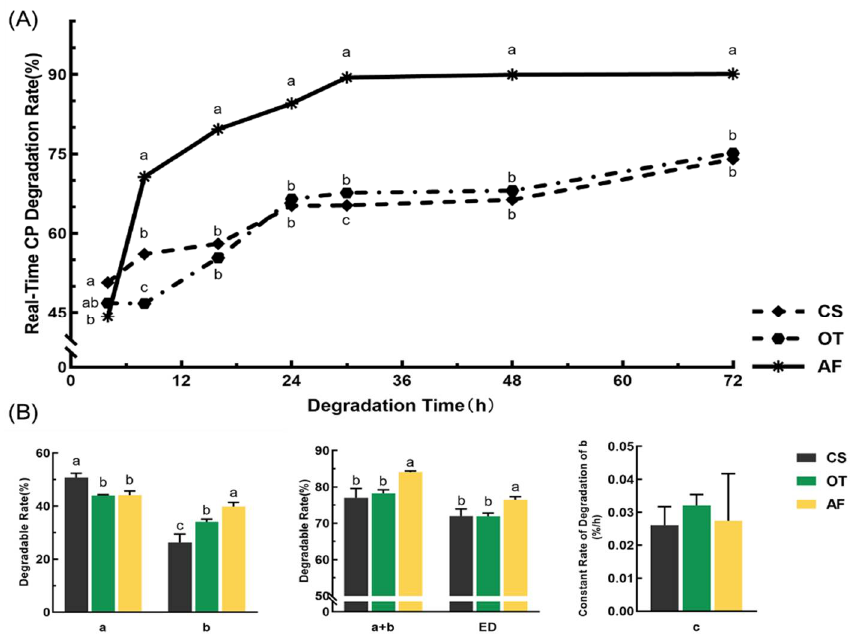
Figure 4. Rumen real-time degradability and degradation parameters of CP for three organic roughages (CS, OT, and AF). ( A ) Real-time degradation rates. ( B ) Degradation parameters. Data in the same parameter (in B ) or time points (in A ) of the superscript mark different lowercase letters indicate a significant difference ( p < 0.05). “a” (%): rapidly degradable fraction; “b” (%): the potentially degradable fraction; “c” (%/h): the constant rate of degradation of “b” (%/h); ED (%): effective degradability.